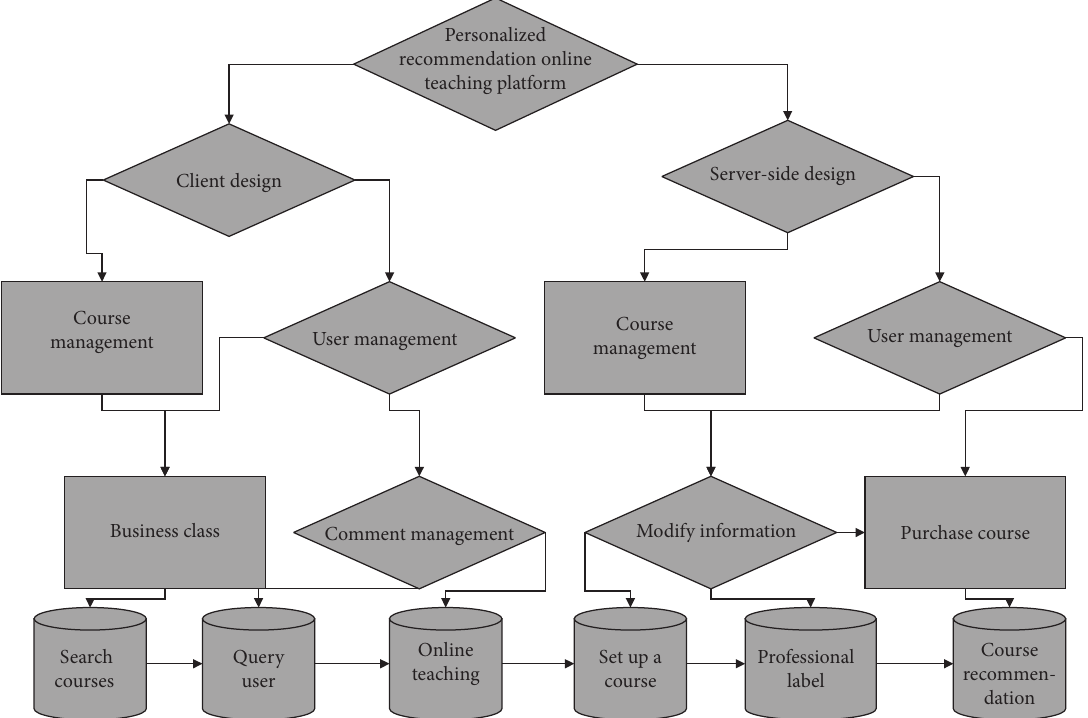
Figure 2: System function module